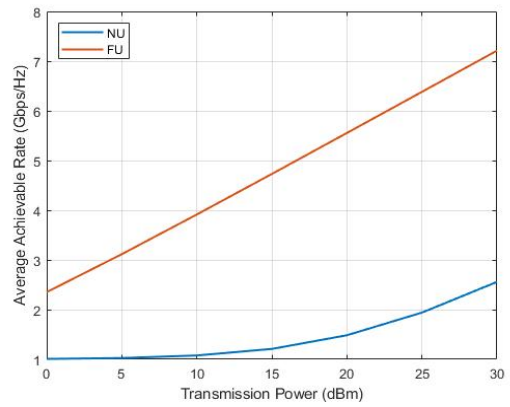
Figure 9. Average rate versus transmission power.